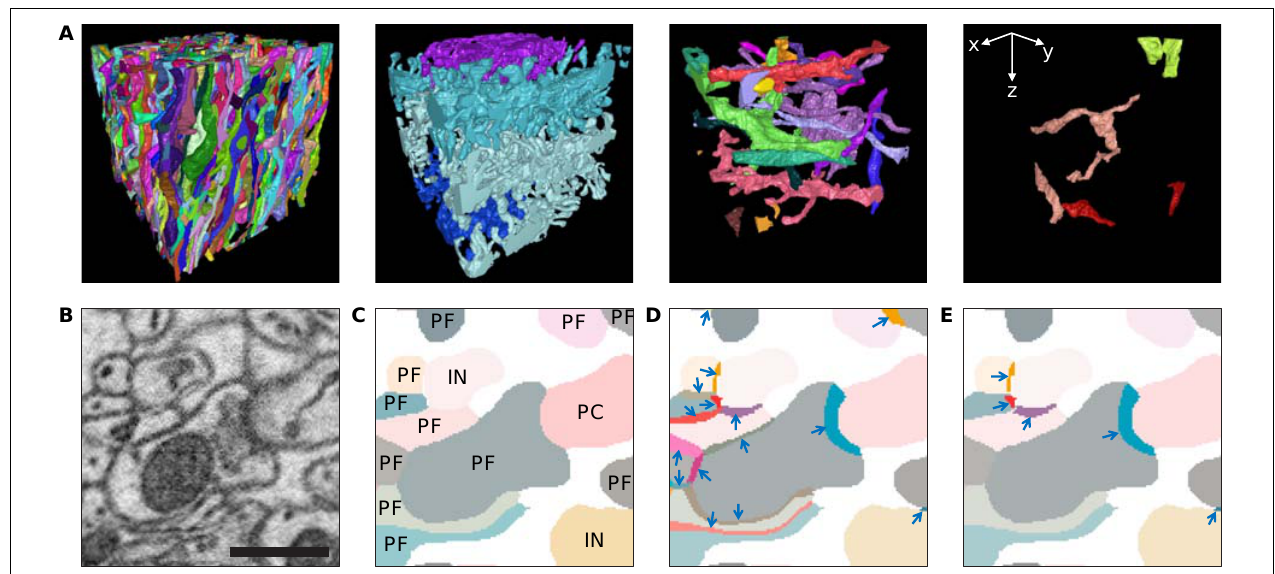
FIGURE 3 | From cell reconstruction to relevant contacts. (A) The 3D renderings of the neuronal fragments in the test set are shown in the four panels grouped by the types. From the left: the parallel fibers (PF), Purkinje cells (PC), inhibitory interneurons (IN), and climbing fibers (CF). (B) A small example patch of EM image. (C) The reconstruction of B that shows the segments of neuronal fragments. The segments are color coded, and their types are shown. White background represents the space without reconstruction (57.6% of the imaged volume is reconstructed.) (D) The color-coded 3D contacts are overlaid on top of the segments of neuronal fragments. The arrows are pointing each contact separately. A contact is the union of the surface voxels from two segments of neuronal fragments that touch each other. Note that some contacts appear thicker than 2 voxels because the contacting voxels to the Z direction are also shown in the XY plane. (E) The relevant contacts are chosen between PF-PC and PF-IN among all the contacts in panel (D) . The PF-PF contacts were discarded because they could not make a synapse and were irrelevant. The type information of the neuronal fragments that form the contacts is kept until the contact is determined as synapse. The synapse types are determined based on the types of neuronal fragments. For example, all the relevant contacts in panel (E) are potentially excitatory synapses because they are PF-PC or PF-IN contacts. A scale bar: 600 nm, 50